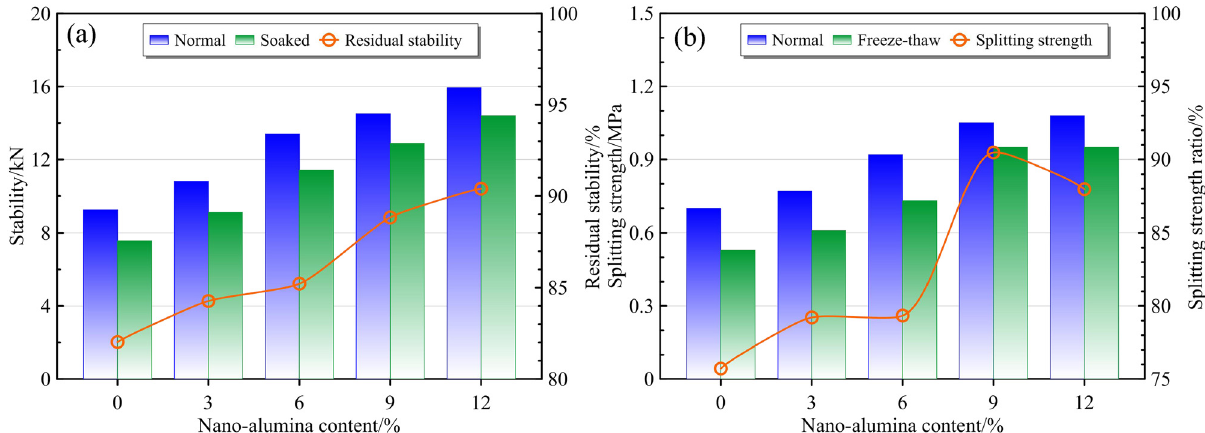
Figure 4: Water stability test: ( a ) Marshall stability test and ( b ) freeze - thaw split test.